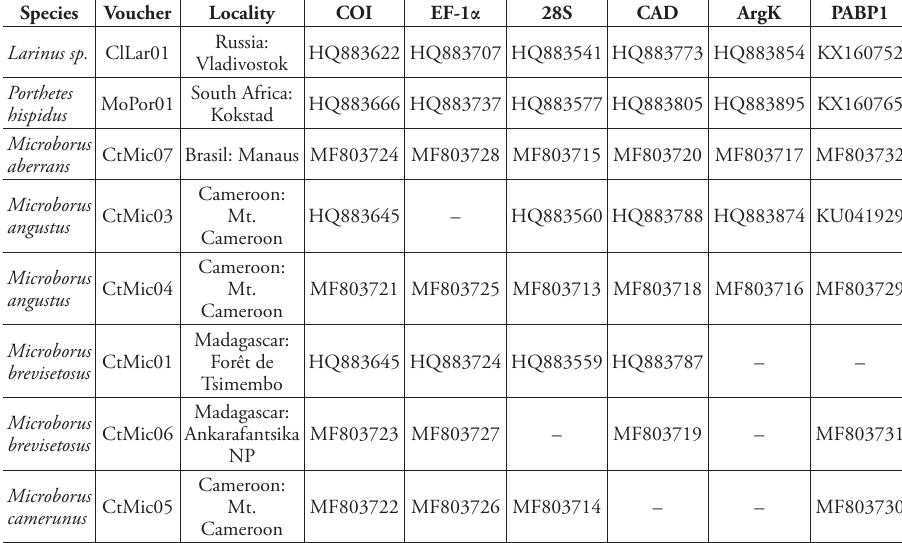
Table 1. Samples included for DNA